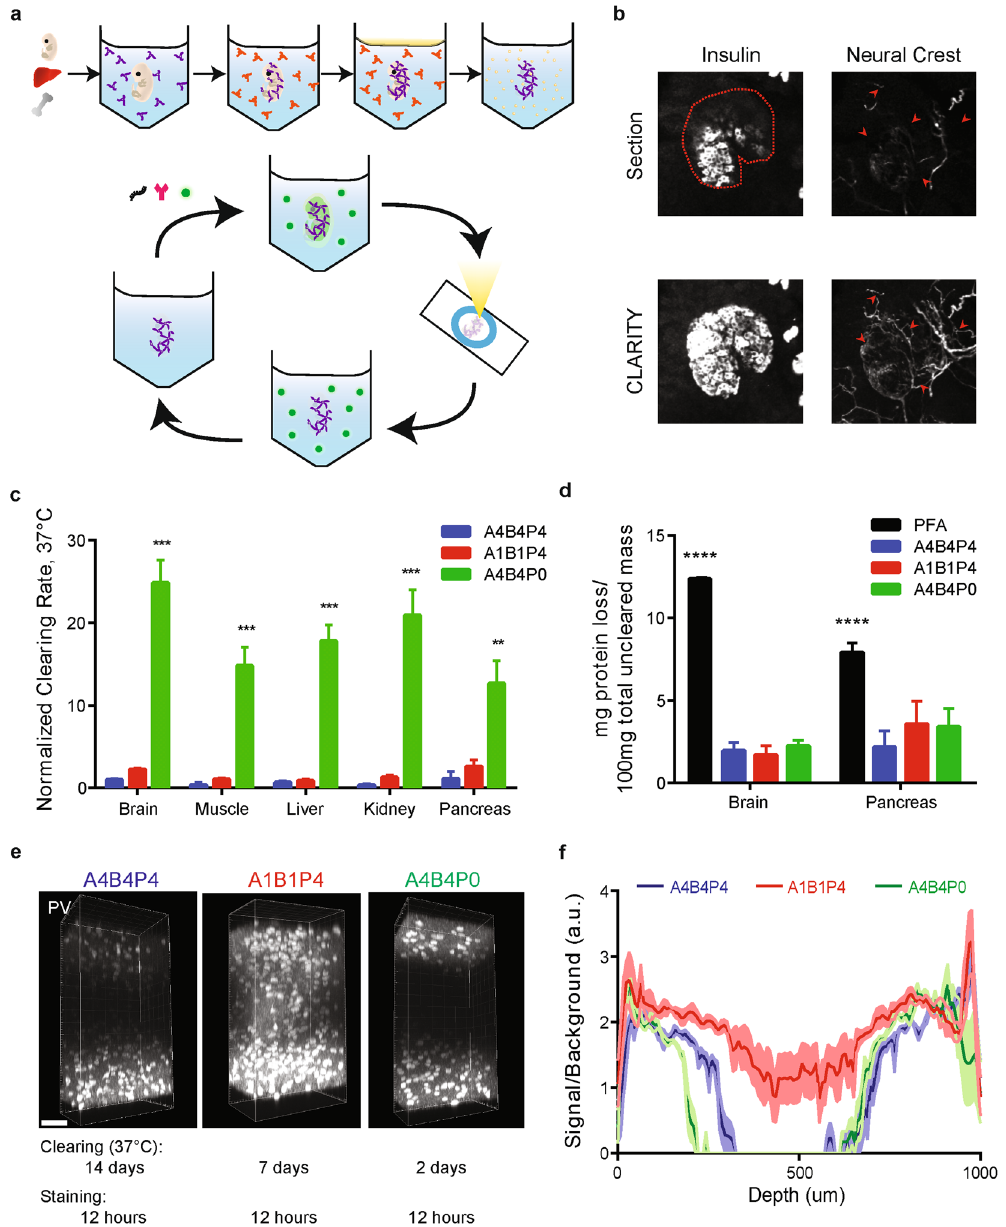
Figure 1. Development of enhanced CLARITY methods for peripheral tissues. ( a ) Simplified CLARITY schematic: First, fixed tissue is placed in a hydrogel monomer solution (purple) that diffuses throughout the tissue. Second, prior to polymerization, samples are transferred to a second hydrogel solution without the capacity for solid polymer formation (orange). Third, the sample is polymerized either through nitrogen flush and degassing or with the use of oil on the surface (indicated in yellow) as an oxygen inhibitor, resulting in formation of a tissue-polymer hybrid with a solid hydrogel interior but in liquid solution, which is ideal for fragile or irregularly shaped tissues. Fourth, tissue is passively cleared. Finally, after optical transparency is achieved, tissue is labeled with molecular probes (RNA, antibody, or dye), mounted on a slide in a refractive index matching solution, and imaged using standard microscopy. The sample can be destained and the process repeated for multiple staining and imaging cycles. ( b ) Virtual thin section (5 μ m) compared to CLARITY volume (250 μ m maximum intensity projection) of the same pancreatic islet image, here from a representative islet in a whole P15 pancreas from a Wnt1-Cre; ROSA-mTmG mouse. CLARITY enables more comprehensive and accurate measurements of structural features compared to section histology. Thin sections can grossly underestimate pancreatic islet sizes (dotted line), and results in incomplete observation of fine microstructures such as complex neural projections (arrowheads). ( c ) CLARITY gel A4B4P0 (green) clears significantly more rapidly compared to both A1B1P4 (red), and A4B4P4 (blue) across multiple tissue types including brain, muscle, liver, kidney (p < 0.00005, unpaired t-test), and pancreas (p < 0.0005, unpaired t-test). n = 6 sections per tissue type and gel. Clearing reaction rates were determined by fitting UV-spectrophotometry measurements over time to a first order transformation reaction kinetics equation y = Y max (1 − e − kt )